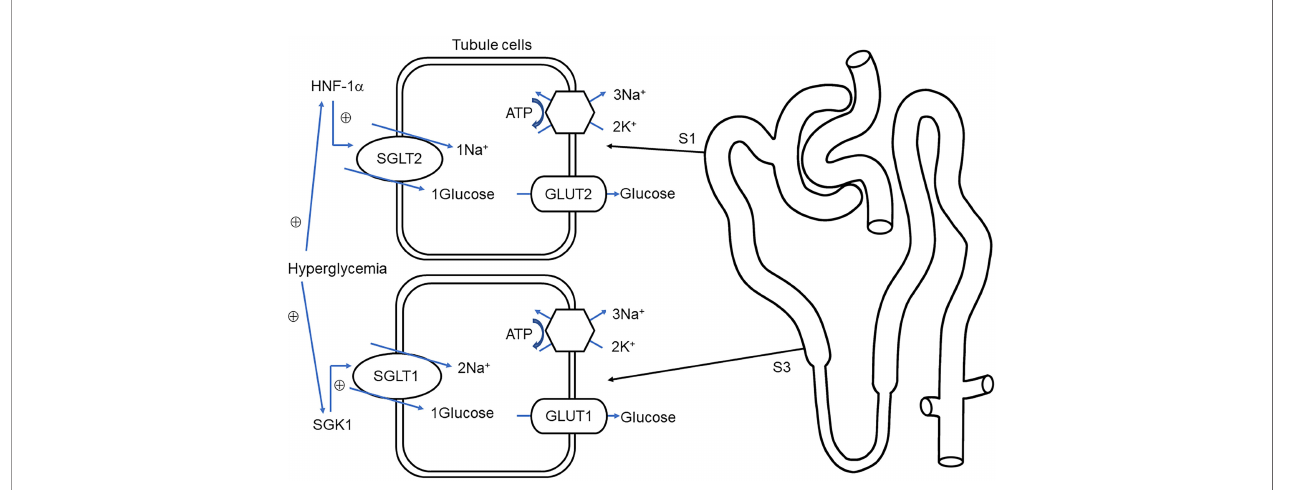
FIGURE 1 | Overview of glucose transport in proximal tubules. Sodium – glucose cotransporter 1/2 (SGLT1, SGLT2) protein located on the brush border membrane is responsible for reabsorption of glucose and sodium in the early renal proximal tubule (S1) and distal proximal tubule (S3), respectively. The glucose on the S1 and S3 correspondingly combined with glucose transporter 2/1 (GLUT2, GLUT1) into the renal interstitial (38). Na + -K + -ATPase, located in the basolateral membrane maintains the potential gradient and concentration gradient of sodium ions and promotes the passive transport of sodium ions. Under hyperglycemia conditions, hepatocyte nuclear factor 1 alpha (HNF-1 a ), serum, and glucocorticoid-induced kinase-1 (SGK1) stimulate the upregulation of SGLT2 and SGLT1, respectively, thereby increasing glucose reabsorption (39, 40).